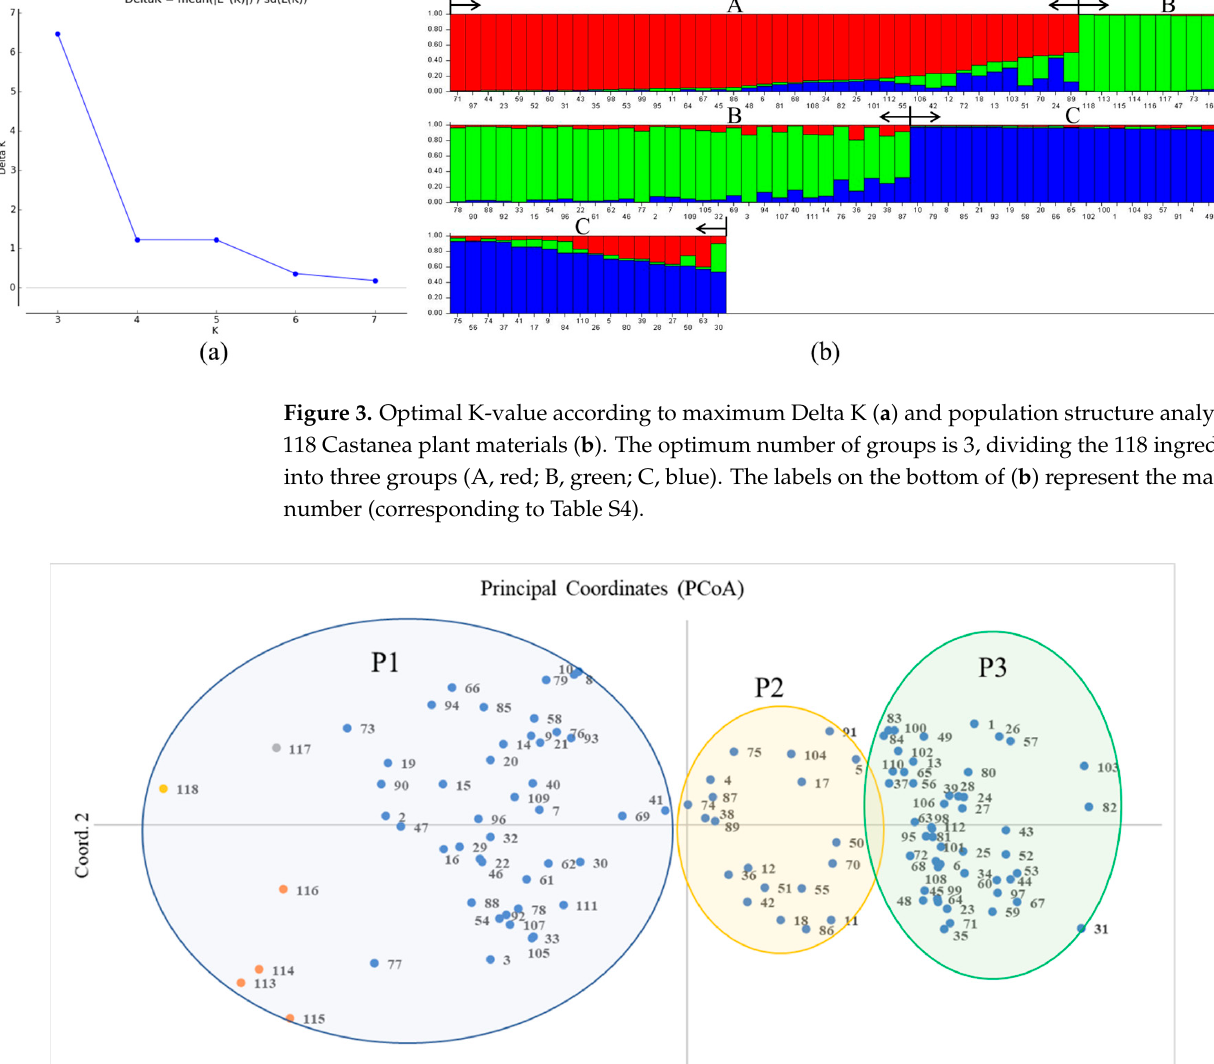
Figure 5. NJ clustering analysis of 118 Castanea plant materials. The labels in the fi gure represent the material number (corresponding to Table S4).